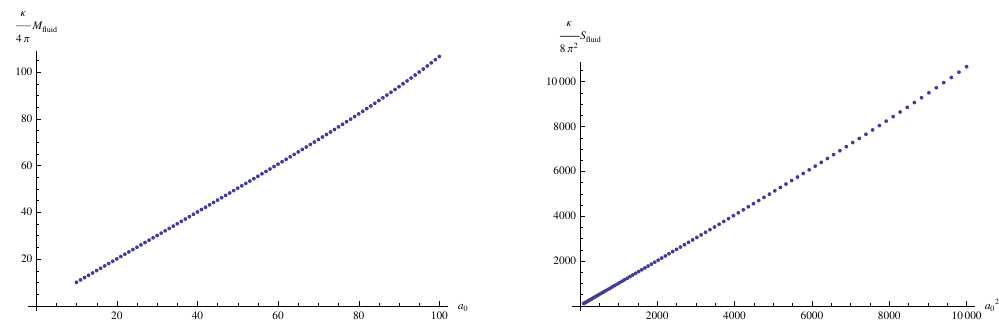
Figure 18 . The dependence of total mass M (cid:13)uid and the entropy S (cid:13)uid of the (cid:13)uid on a 0 for (cid:11) = 0 : 05. The surface r s (cid:3) is located on the neck, r (cid:3) s = a (cid:3) .